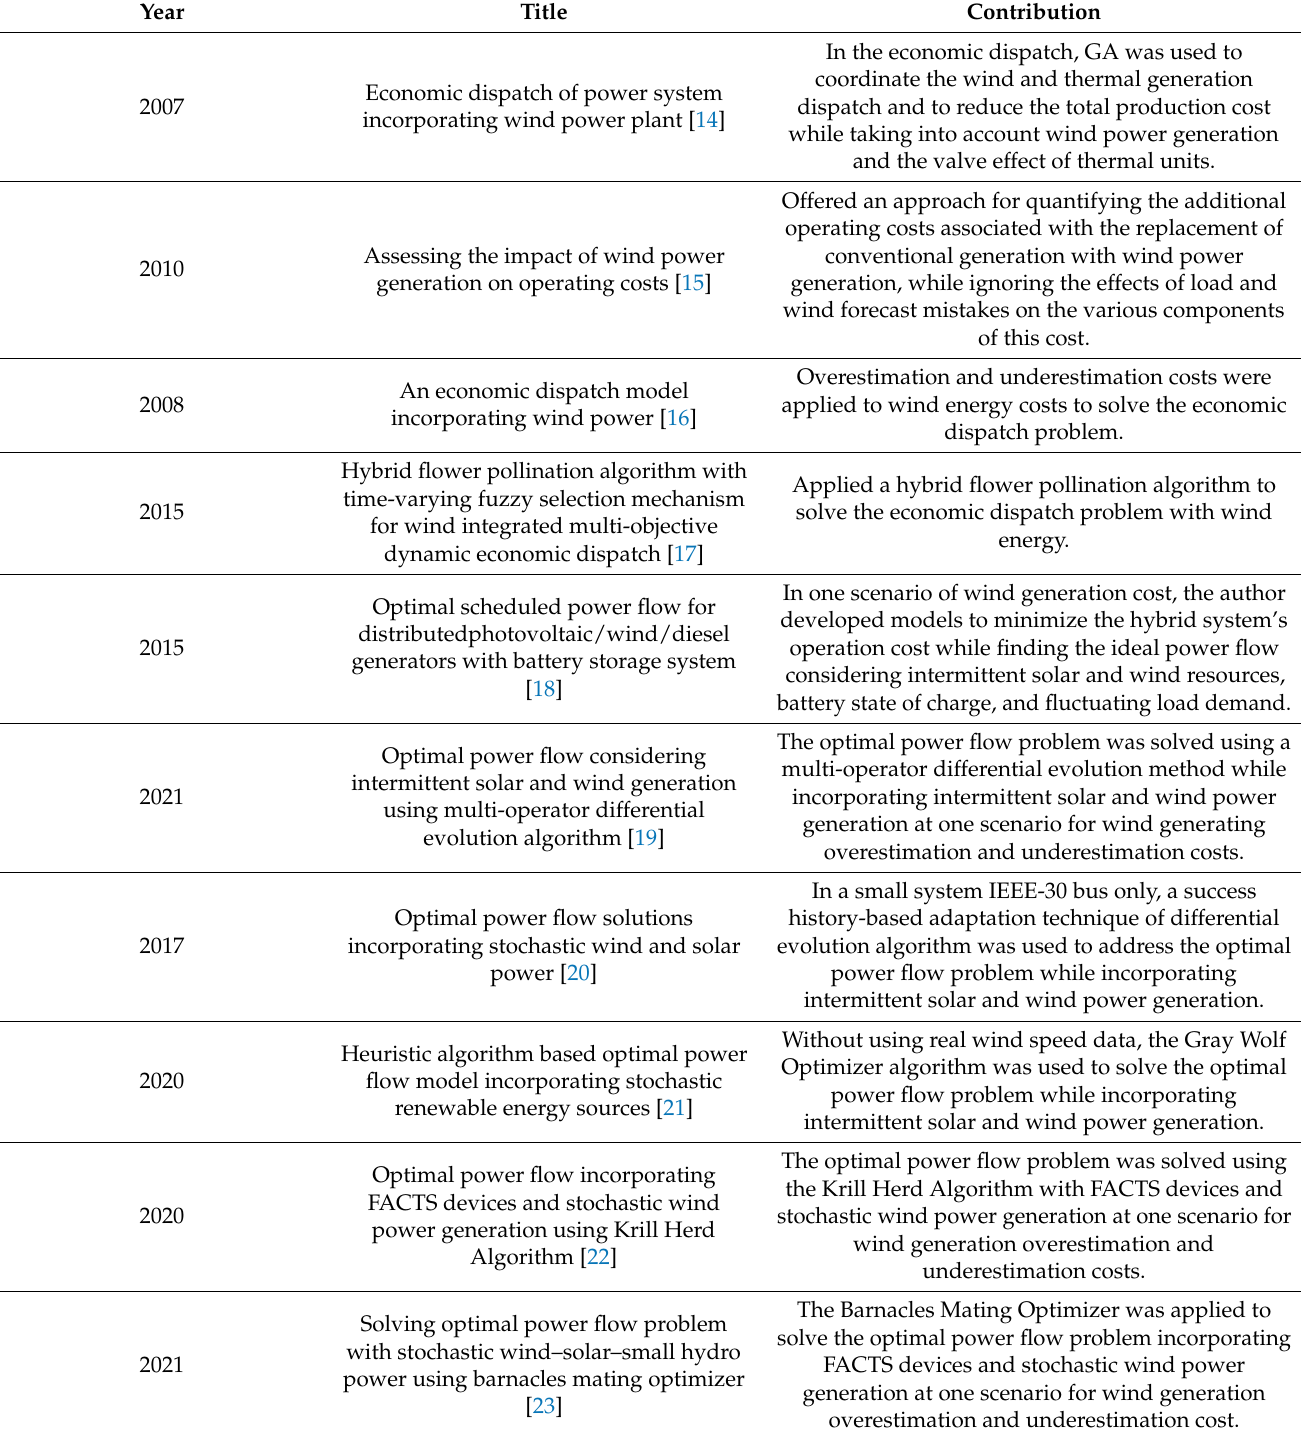
Table 1. Literature